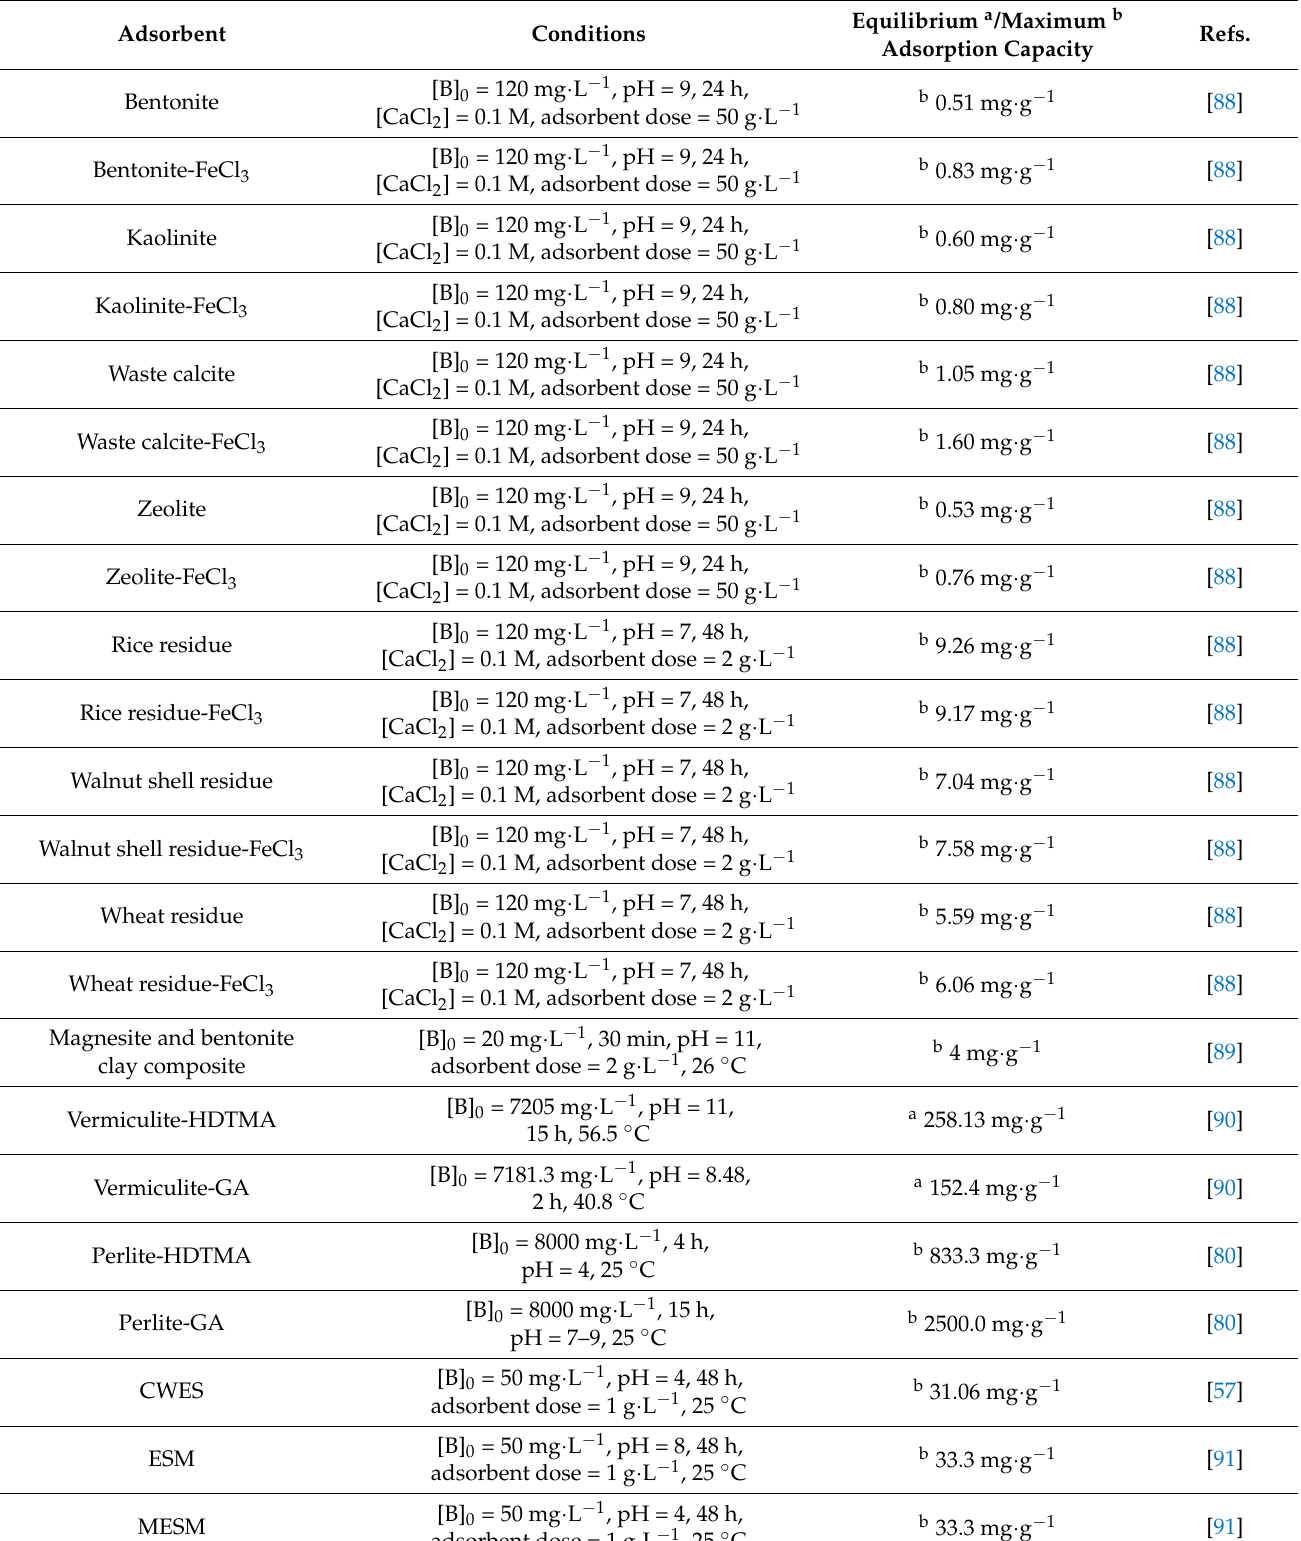
Table 12. Performances of natural materials adsorbents in boron